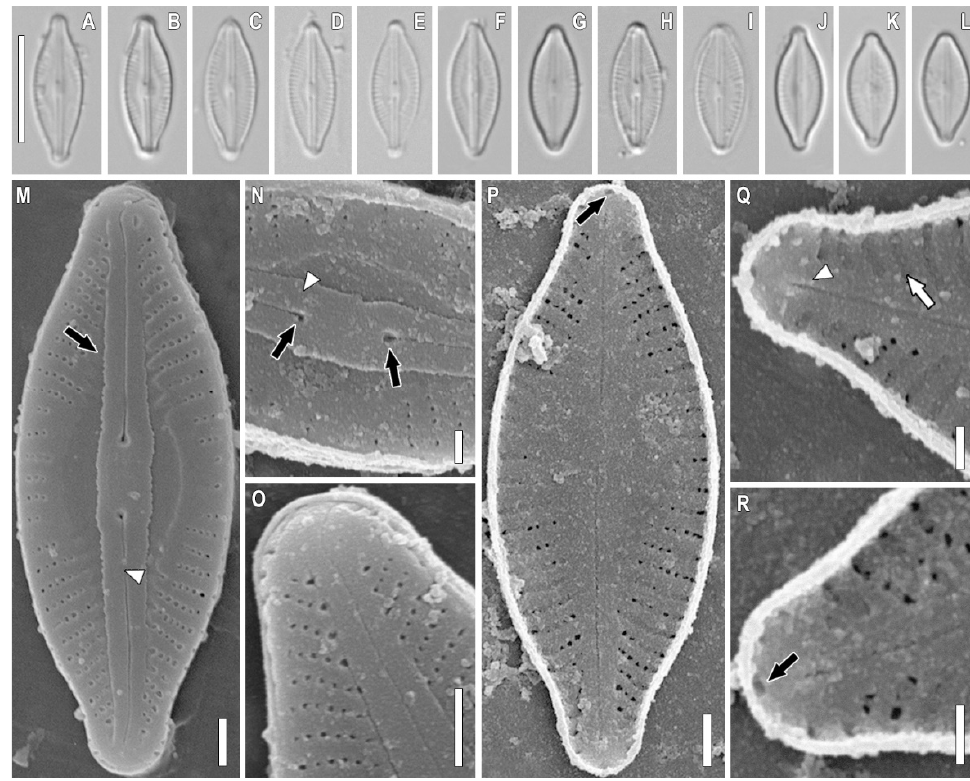
Figure 2. Sellaphora terrestris sp. nov. Strain VP 272. Slide no. 07030. ( A – L ). Light microscopy, differ- ential interference contrast, size diminution series ( M – O ). Scanning electron microscopy, external views. ( P – R ). Scanning electron microscopy, internal views. ( M ). Black arrow shows the longitudinal grooves in the axial area. White arrowhead shows the raphe. ( N ). Black arrow shows the proximal raphe ends. White arrowhead shows the conopeum. ( P ). Black arrow shows the rounded apical pit. ( Q ). White arrowhead shows the helictoglossa. ( R ). Black arrow shows the rounded apical pit. Scale bar ( A – L ) = 10 μ m; ( Q ) = 2 μ m; ( M , O , P ) = 1 μ m; ( N , R , S ) = 0.5 μ m.